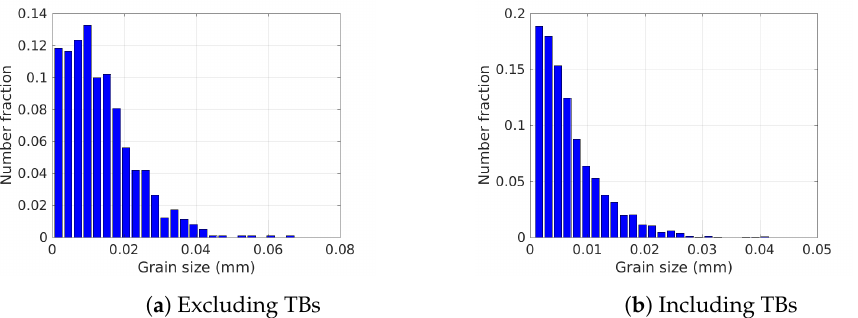
Figure 7. Initial grain size distributions ( a ) excluding TBs and ( b ) all grain boundaries obtained from the initial EBSD map shown in Figure